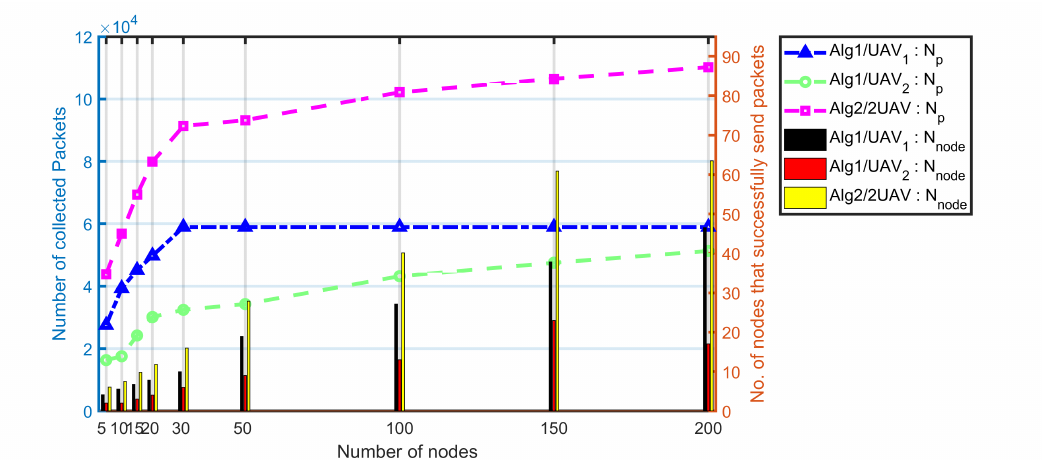
Figure 10. The impact of UAV 1 , UAV 2 and multi-UAVs of proposed algorithm on network size. In these simulations, “Alg1” is the combination of proposed Balance and PCdFS algorithms, “Alg2” is the combination of proposed prioritized-based multiple contact-duration frame selection mechanisms (PMCdFS), PCdFS, and Balance